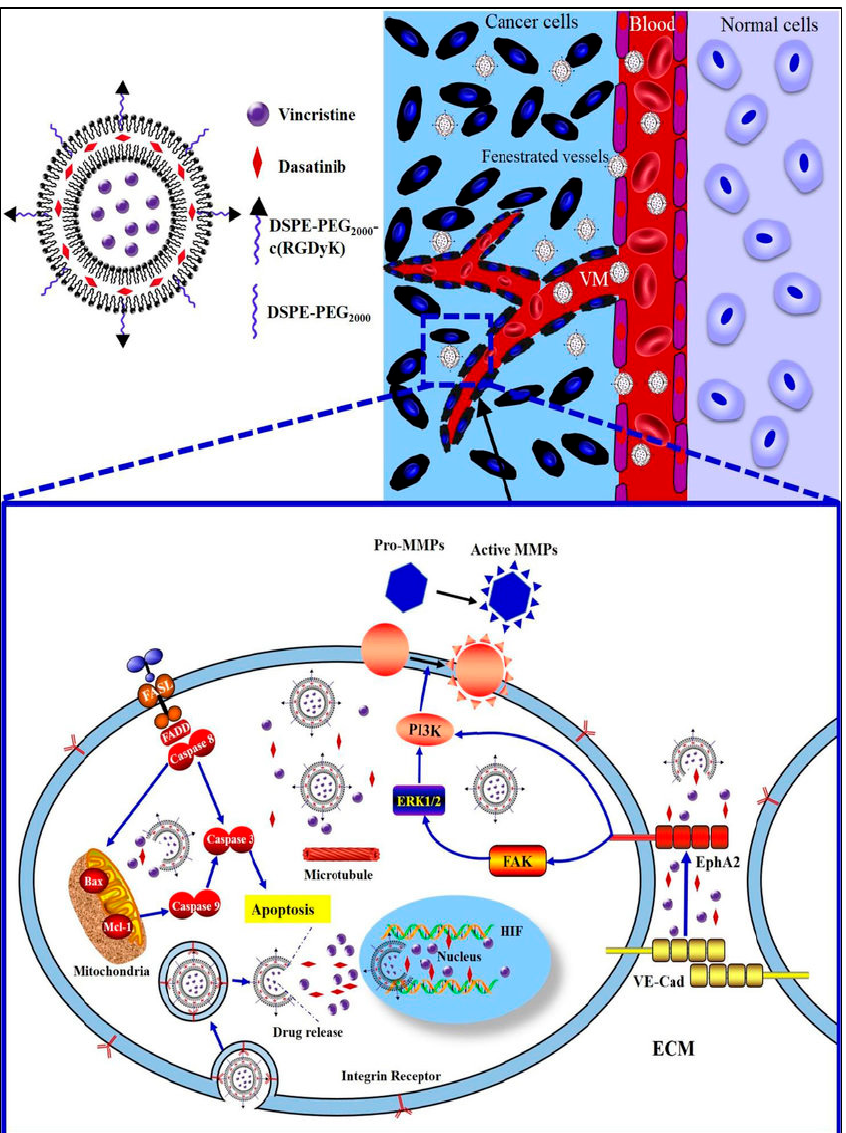
Figure 7. Schematic diagram showing mechanism of functional vincristine plus dasatinib liposomes in the elimination of VM channel for the treatment of TNBC. This work is licensed under Creative Commons Attribution 3.0 License (CC BY 3.0). This work is attributed to Ref . [237].